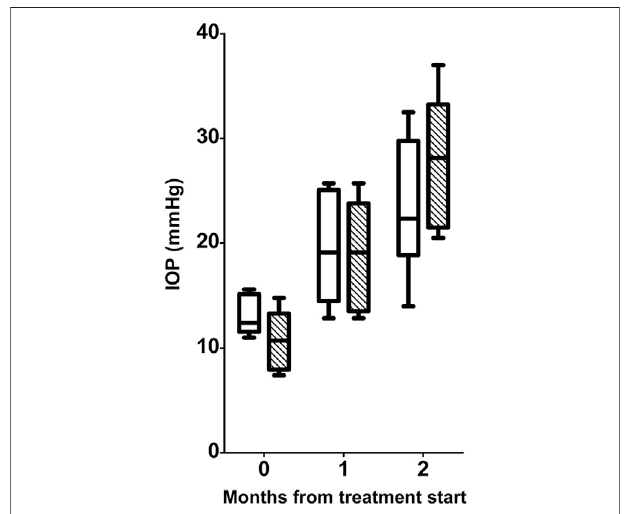
FIGURE 1 | Longitudinal analysis of IOP levels in D2 (white boxes) and D2+LG (dashed boxes). Box plots describe the statistical distribution of data deriving from the average of IOPs measured in individual right and left eyes of n (cid:1) 6 mice. Statistical differences were tested using two-way ANOVA